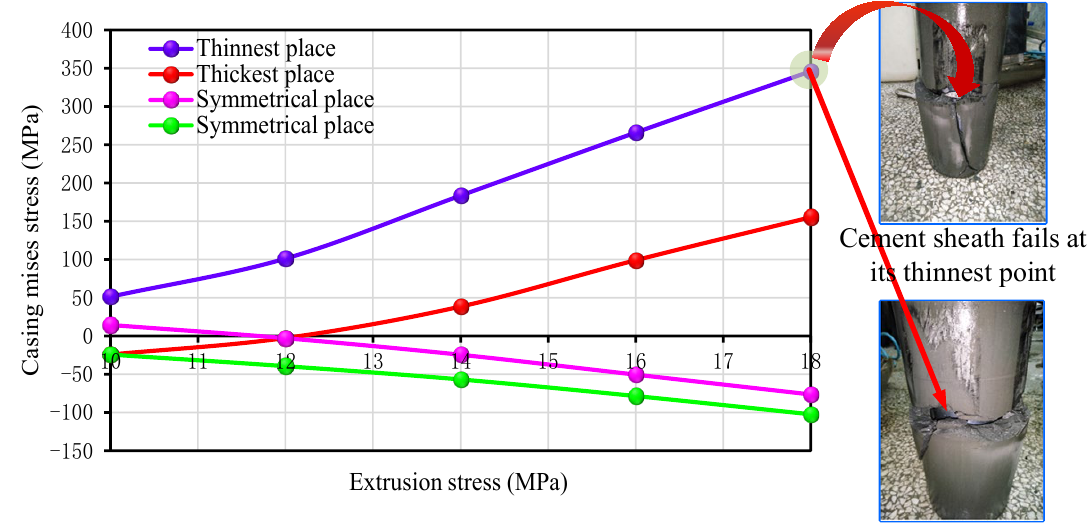
Figure 6. Casing mises stress distribution when 67% casing is centered.